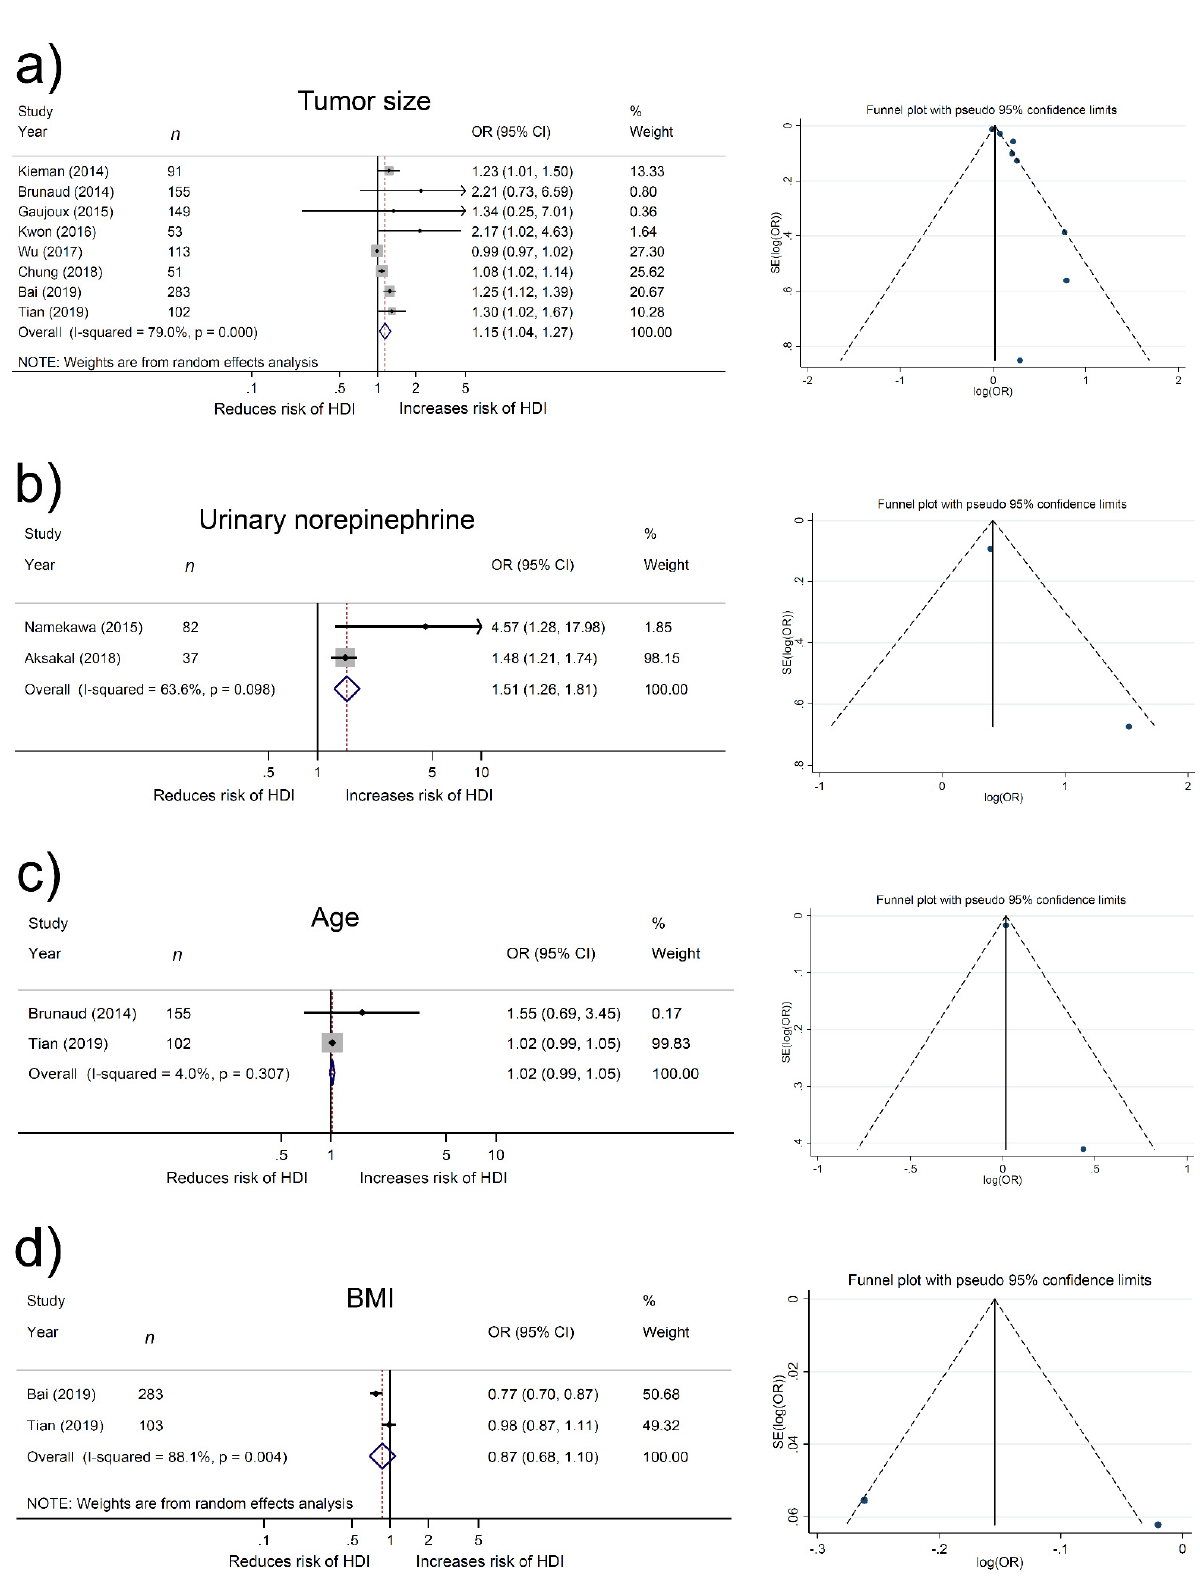
Figure 2. Forest and funnel plots showing the association of ( a ) tumor size, ( b ) urinary norepinephrine, ( c ) age, and ( d ) body mass index (BMI) with hemodynamic instability (HDI) in pheochromocytoma. OR, odds ratio